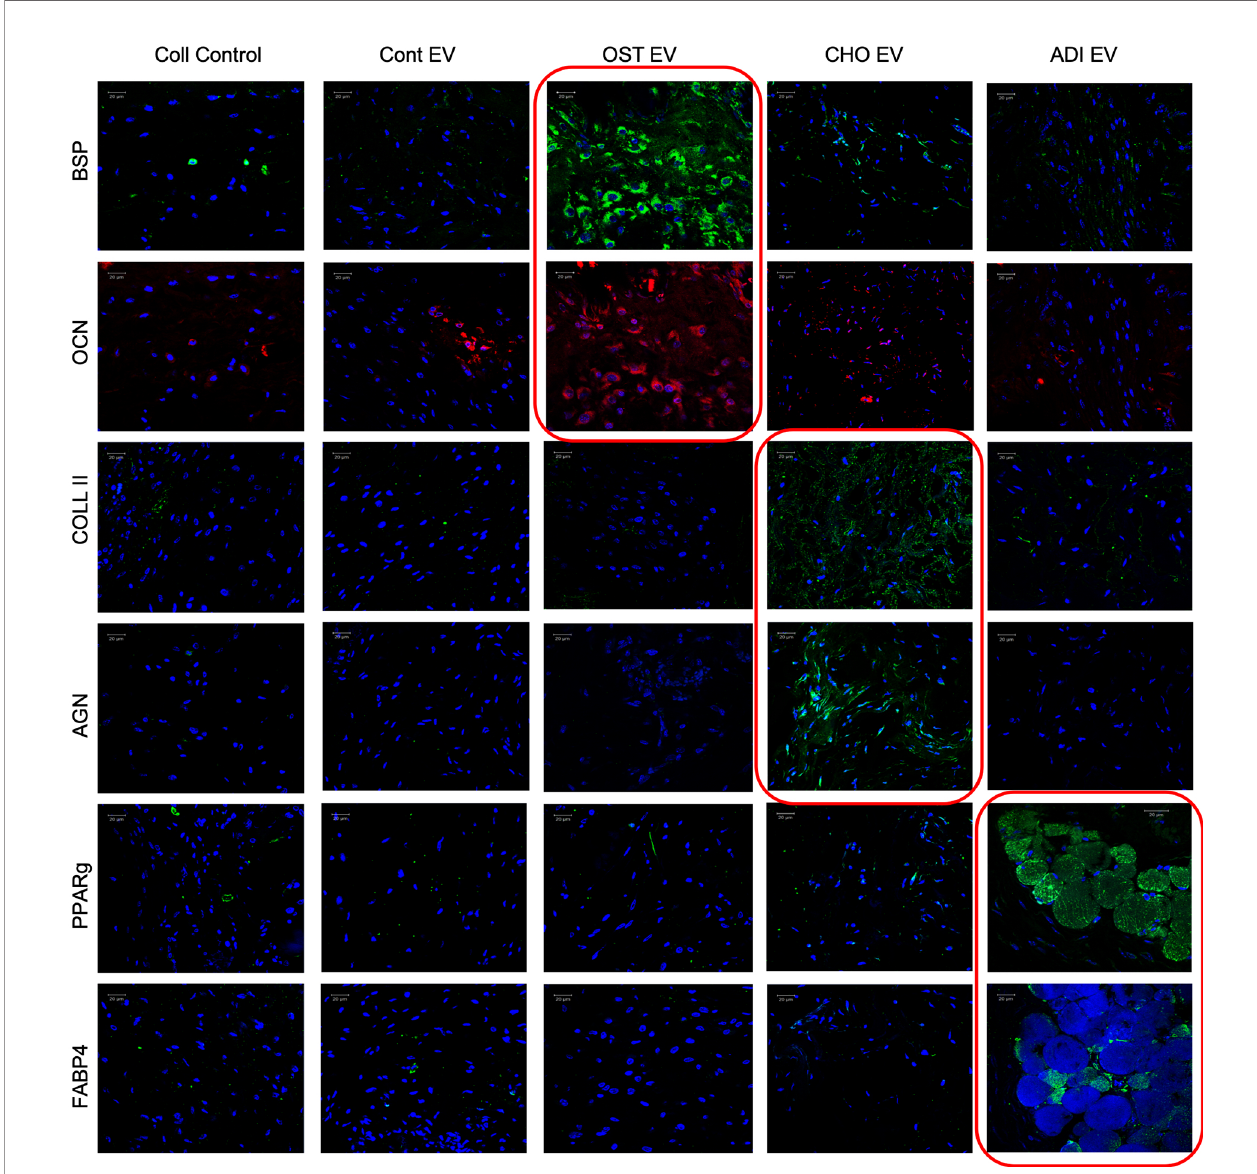
FIGURE 6 | Lineage-speci fi c differentiation of human mesenchymal stem cells (HMSCs) in vivo: Confocal micrographs representing immunohistochemical staining for the presence of lineage speci fi c proteins in the tissue explants from the subcutaneous implantation of HMSCs with and without respective control and lineage speci fi c EVs. The red boxed images represent lineage speci fi c protein expression. In all images, blue represents DAPI nuclear staining and red or green represents the immunolabeled protein. Scale bar represents 20 µm in all